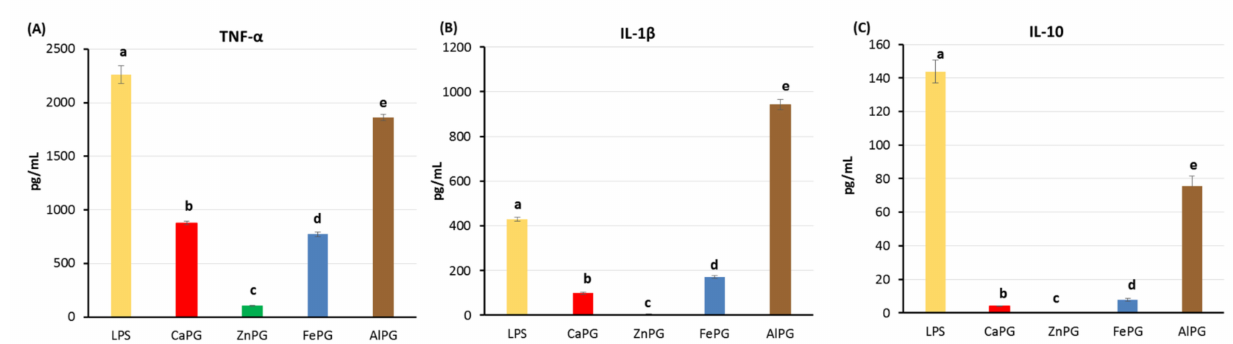
Figure 8. Effect of CaPG, ZnPG, FePG, and AlPG beads on tumor necrosis factor- α (TNF- α , ( A )), interleukin-1 β (IL-1 β ( B )), and interleukin-10 (IL-10, ( C )) production by human peripheral blood mononuclear cells (hPBMCs) stimulated with LPS 2 µ g/mL. Different letters indicate significant differences between pectin gel beads prepared with different cations ( p <